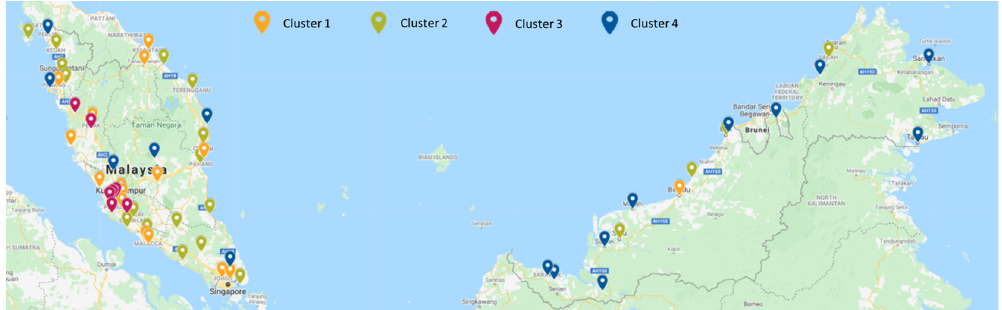
Figure 12. Air monitoring stations’ locations colored according to clusters for PM 10 daily average time series data with DTW and FKM as its clustering algorithm. time series data with DTW and FKM as its clustering